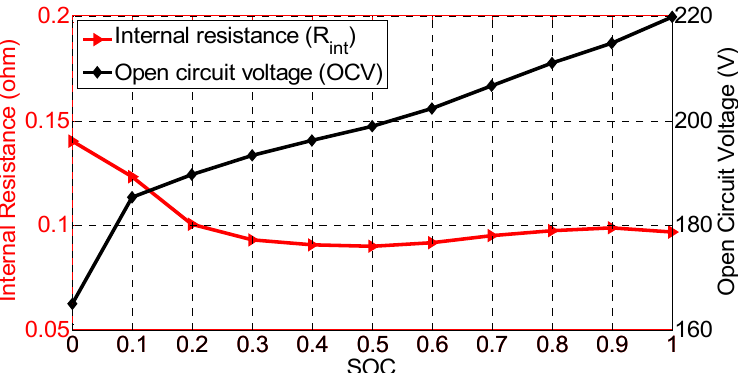
R variation with state of charge (SOC). Figure 2. OCV and R int variation with state of charge int